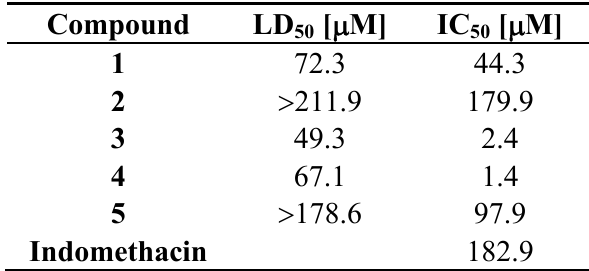
Table 2. Cell viability and in vitro anti-inflammatory activities of compound 1 – 5 decrease nitrite of LPS-stimulated production in RAW 264.7